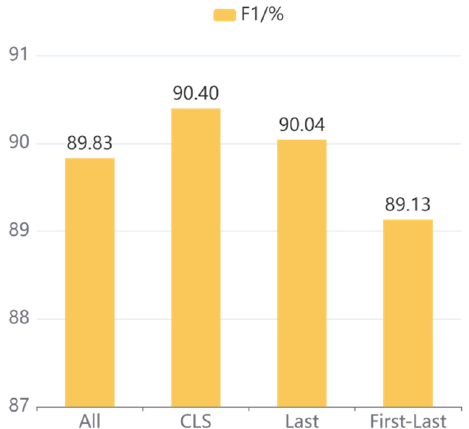
Figure 9. Comparison results for different sentence vectors on CCKS2019.